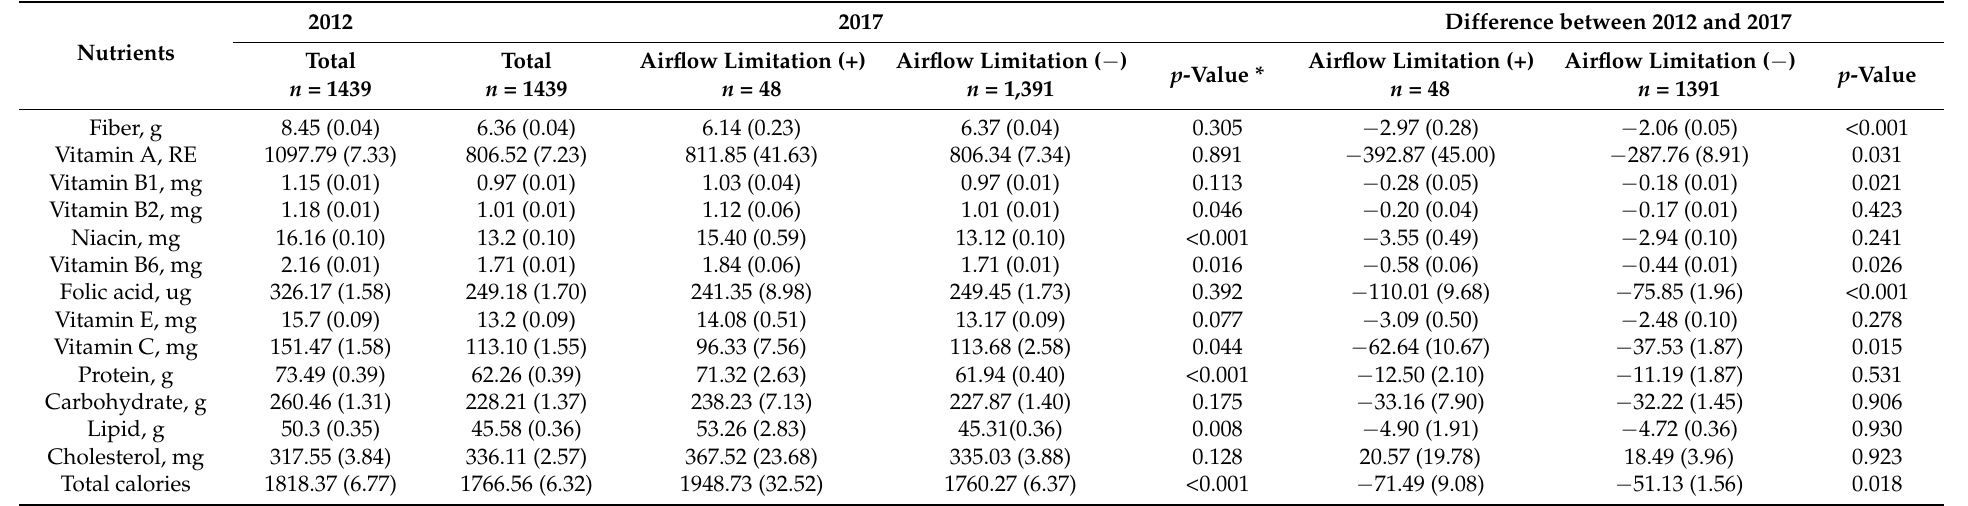
Table 2. Dietary fiber and other nutrient intake differences between 2012 and 2017 in the study